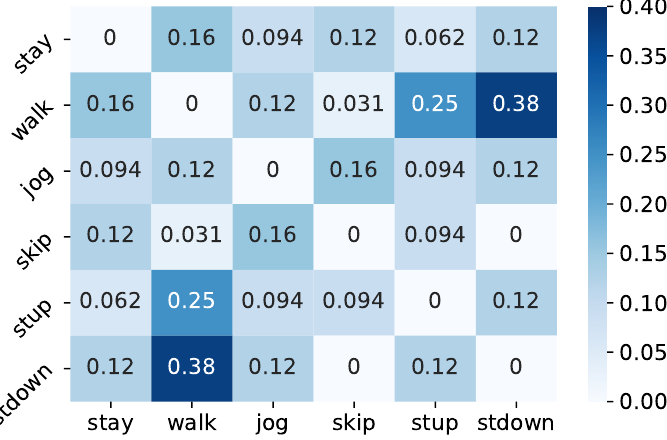
Figure 6. Percentage of two classes merged at Level 2 of the top 1% class